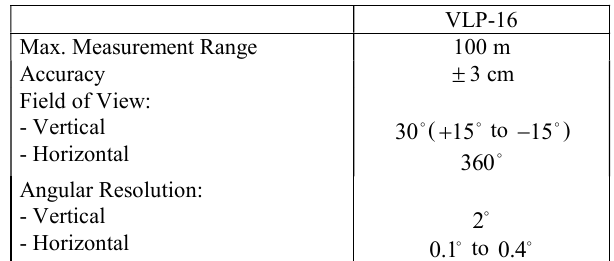
Table 2 . Performance characteristics of Velodyne